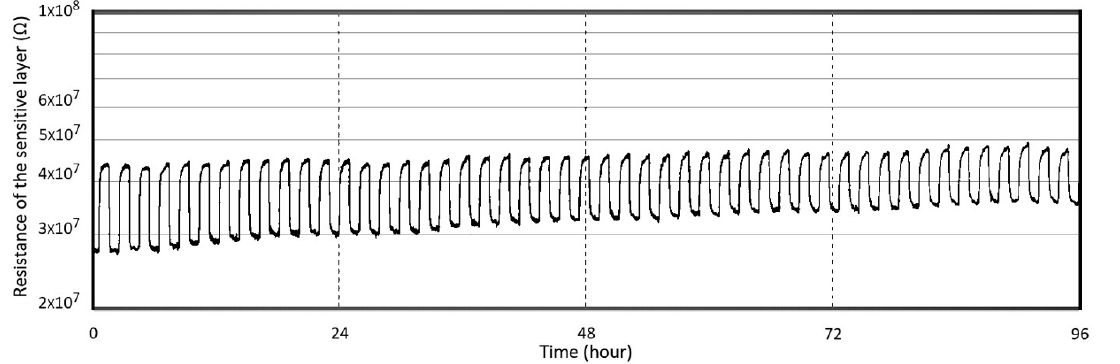
Figure 11. Response of the composite heater sensor towards 20 ppm of formaldehyde when operating in heat pulsing mode for four days.